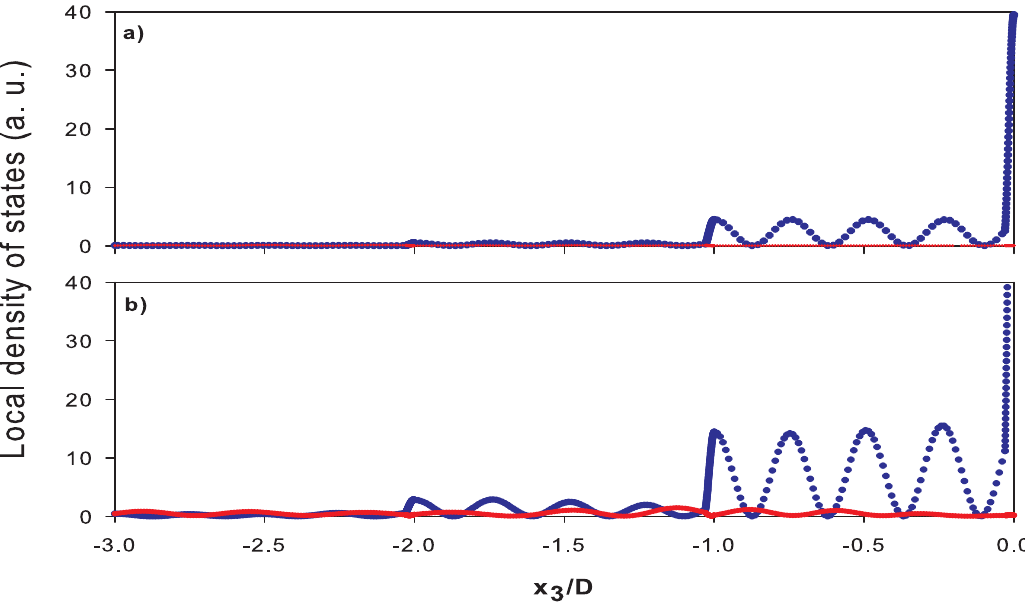
Figure 6. Spatial representation of local density of states for [ k // D = 0, f = 1.0025 THz] ( a ) and [ k // D = 1, f = 1.0102 THz] ( b ). Blue and red curves correspond to longitudinal and transverse components of the waves,